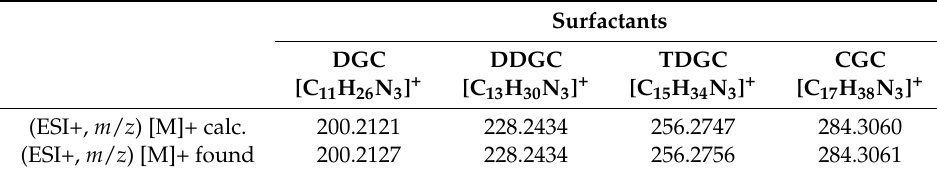
Results of high-resolution mass spectroscopy experiments with the guanidinium surfactants